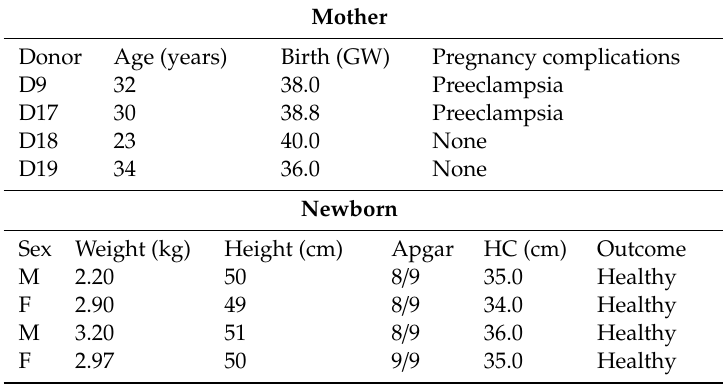
Table 2. Clinical data of control women during pregnancy and physical findings of their